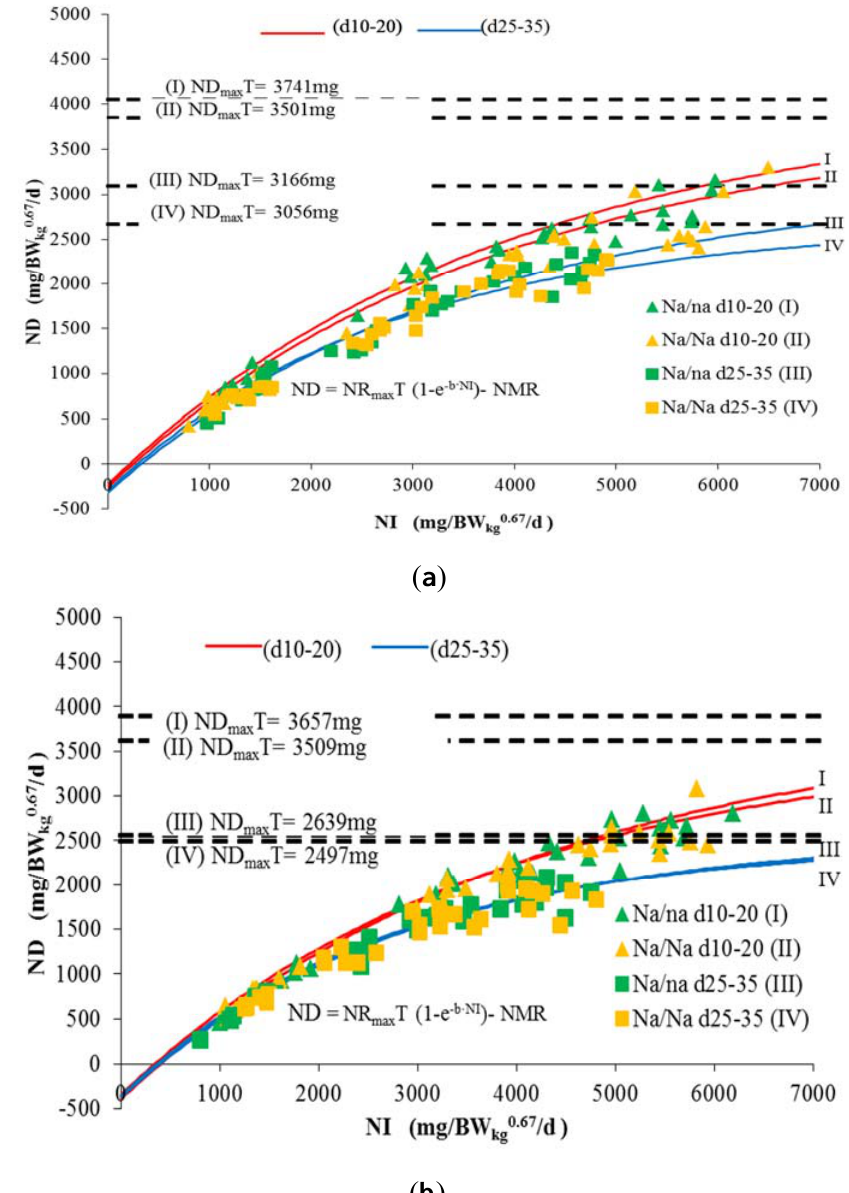
Figure 2. Estimation of the theoretical potential for daily N deposition (ND max T) in naked neck chickens of different sexes, genotypes and age periods based on daily N deposition (balance) dependent on daily N intake (NI). NR max T = theoretical maximum for daily N retention; e = basic number of natural logarithm (ln); b = slope of the N-retention curve (indicating the feed protein quality independent of NI); NMR = N maintenance requirement. ( a ) Males; ( b ) Females.